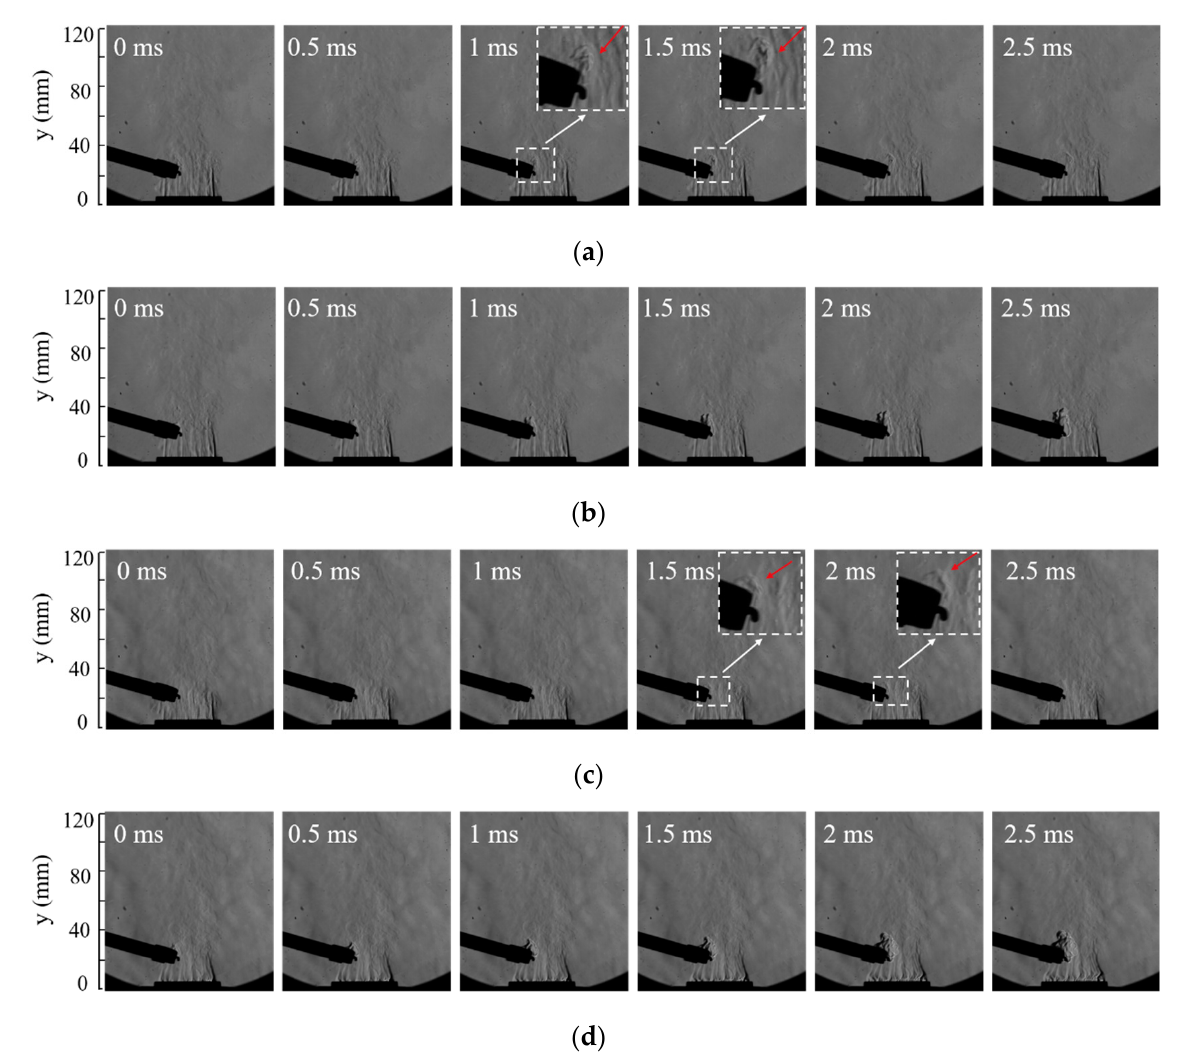
Figure 8. Schlieren images for: ( a ) ignition failure of 30 Hz; ( b ) ignition success of 30 Hz; ( c ) ignition failure of 50 Hz; ( d ) ignition success of 50 Hz.